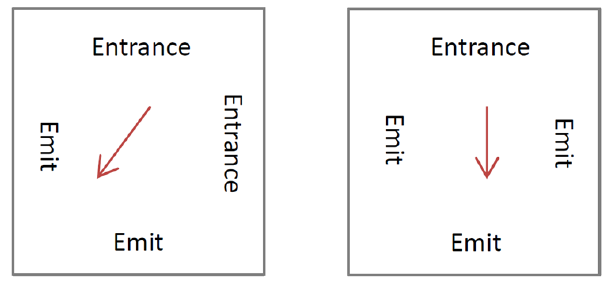
Figure 3. Flow boundary